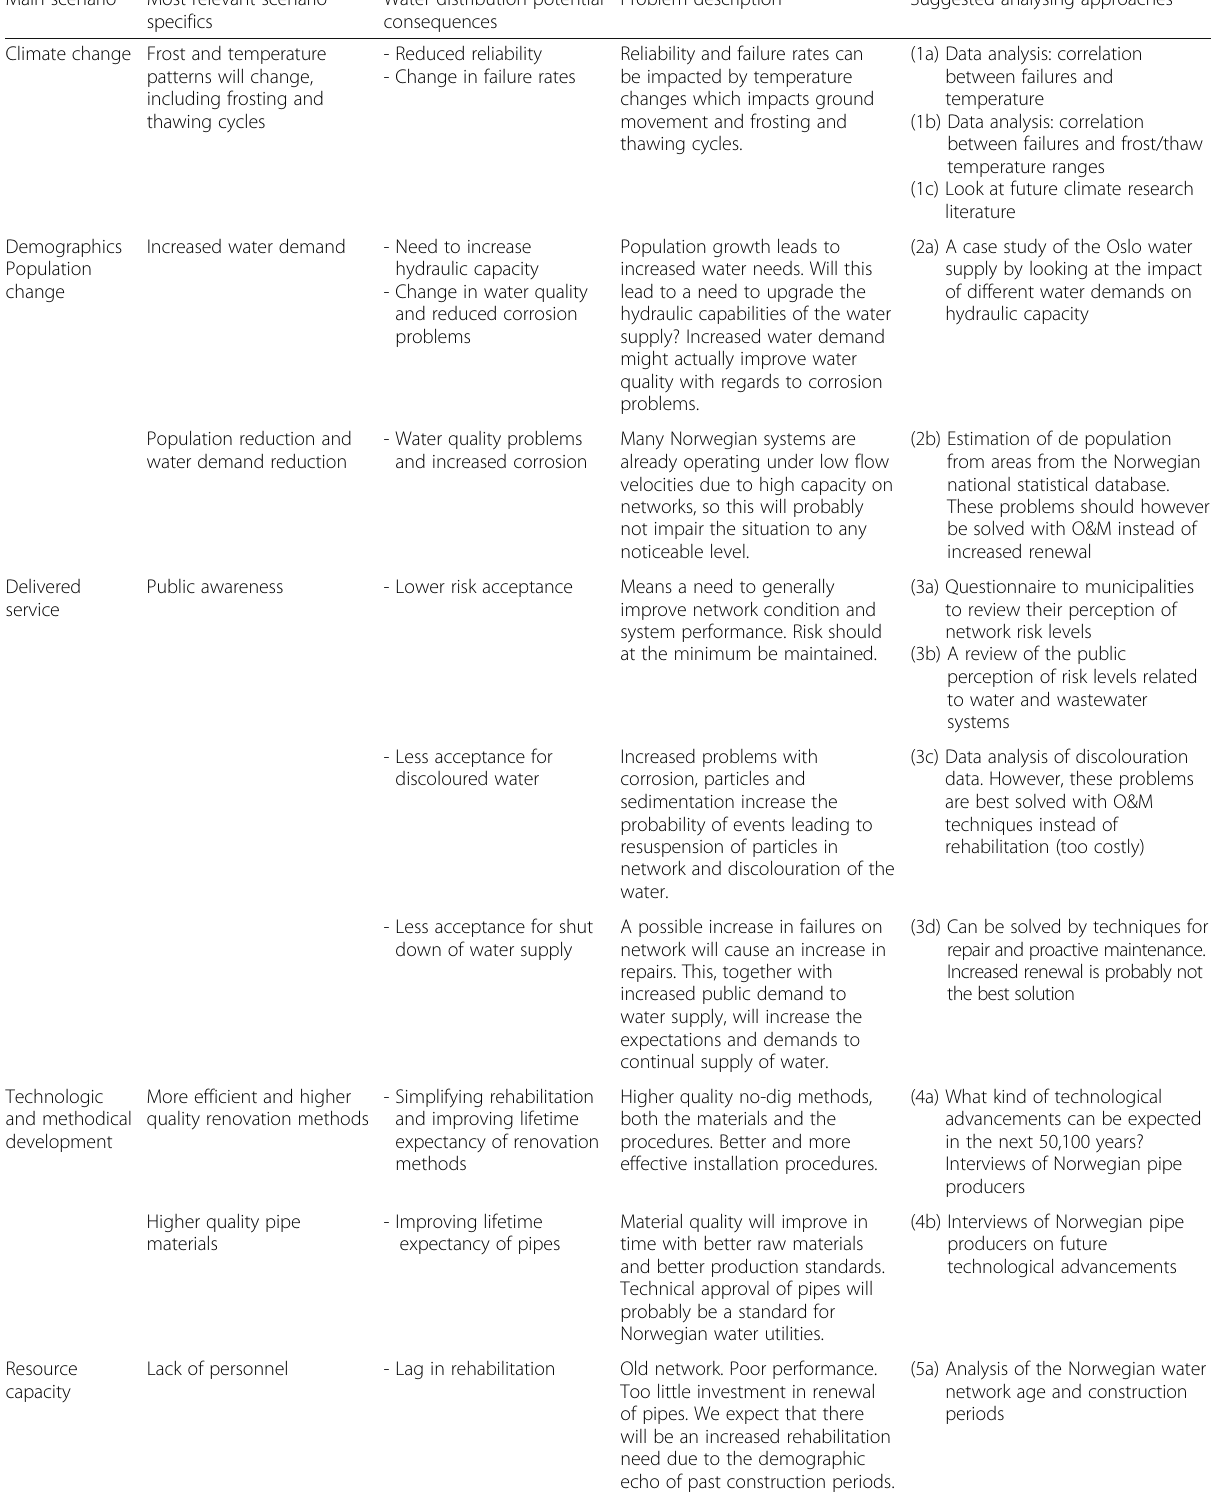
Table 3 Relevant future scenarios, potential consequences and analysing approaches identified in the case